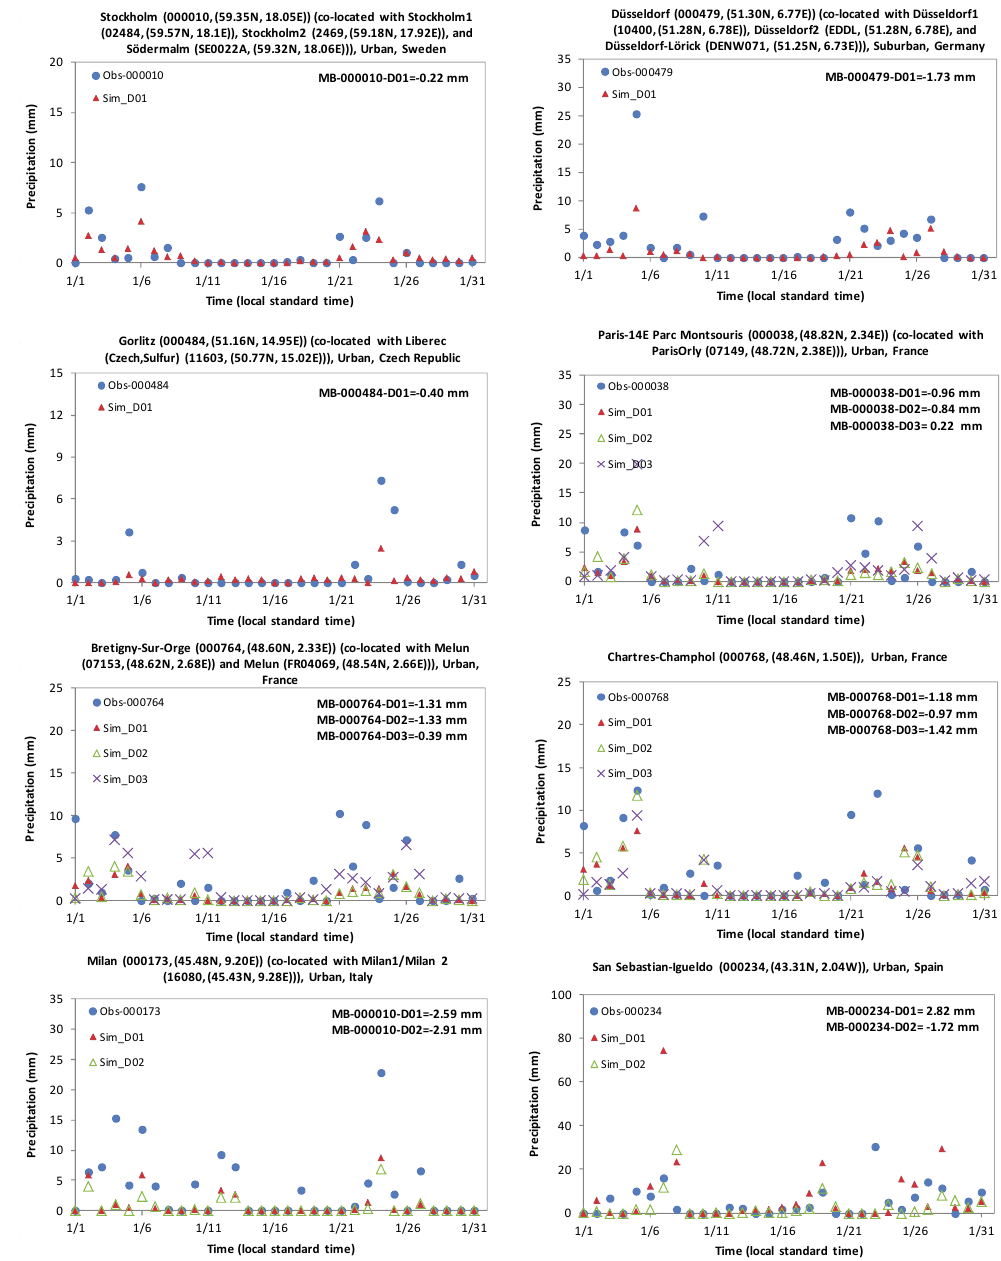
Figure 16. Simulated and observed daily precipitation in January 2001 at selected sites. Fig. 16. Simulated and observed daily precipitation in January 2001 at selected